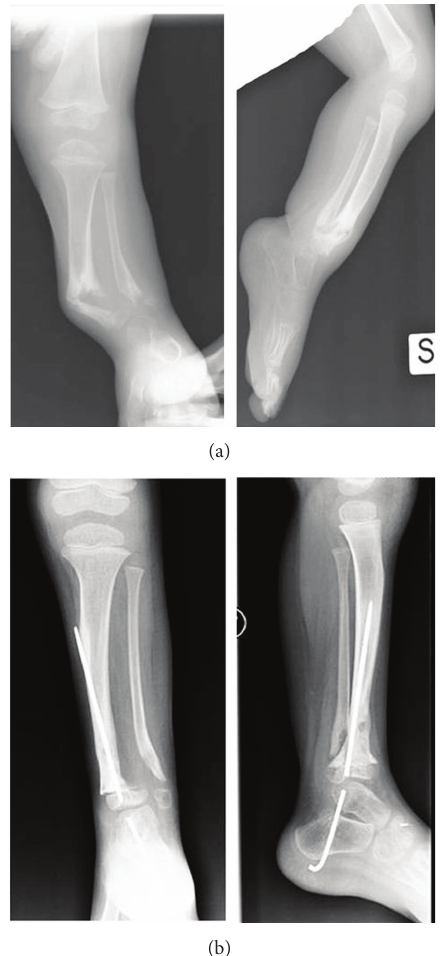
Figure 2: Clinical effect of the use of combined BM hMSC-based technique. Radiographics of a representative patient affected by NF1 with a tibial pseudarthrosis before (a) and three months (b) after the use of autologous BM hMSCs combined with platelet-rich fibrin and lyophilized